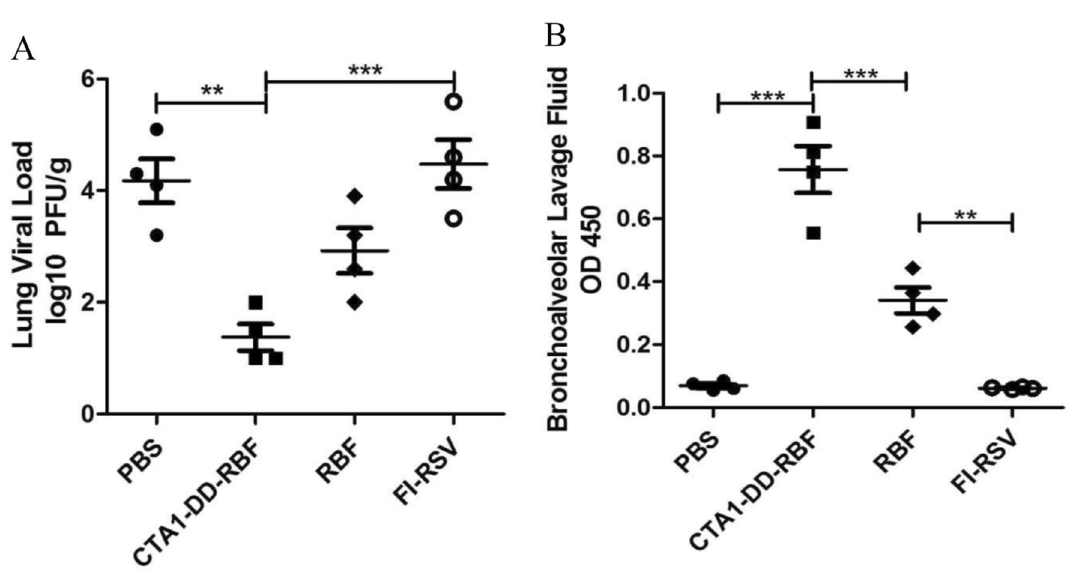
Figure 3. CTA1-DD-RBF reduced hRSV replication and induced neutralizing antibodies in mice. ( A ) The lung viral load was measured on day 4 after hRSV A Long challenge. Each data point indicates a mouse. ( B ) IgA in the bronchoalveolar lavage fluid was detected using ELISA with RBF (100 ng/well) as the coating antigen. Statistically significant differences were measured by one-way ANOVA with the Newman-Keuls posttest, ***p < 0.001. The bars represent the mean values with standard